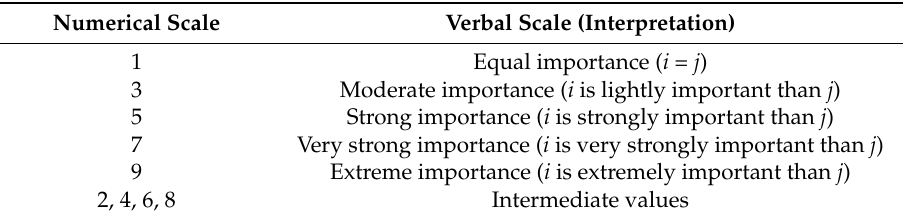
Table 1. Saaty Analytic Hierarchy Process (AHP) numerical